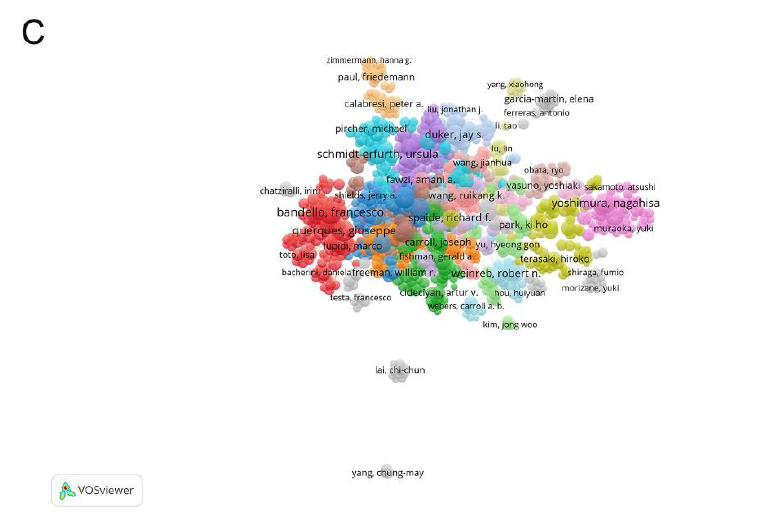
Figure 6. Analysis of Co-authorship relationship. ( A ) Collaboration network of countries/regions; ( B ) Collaboration network of institutions; ( C ) Collaboration network of authors.